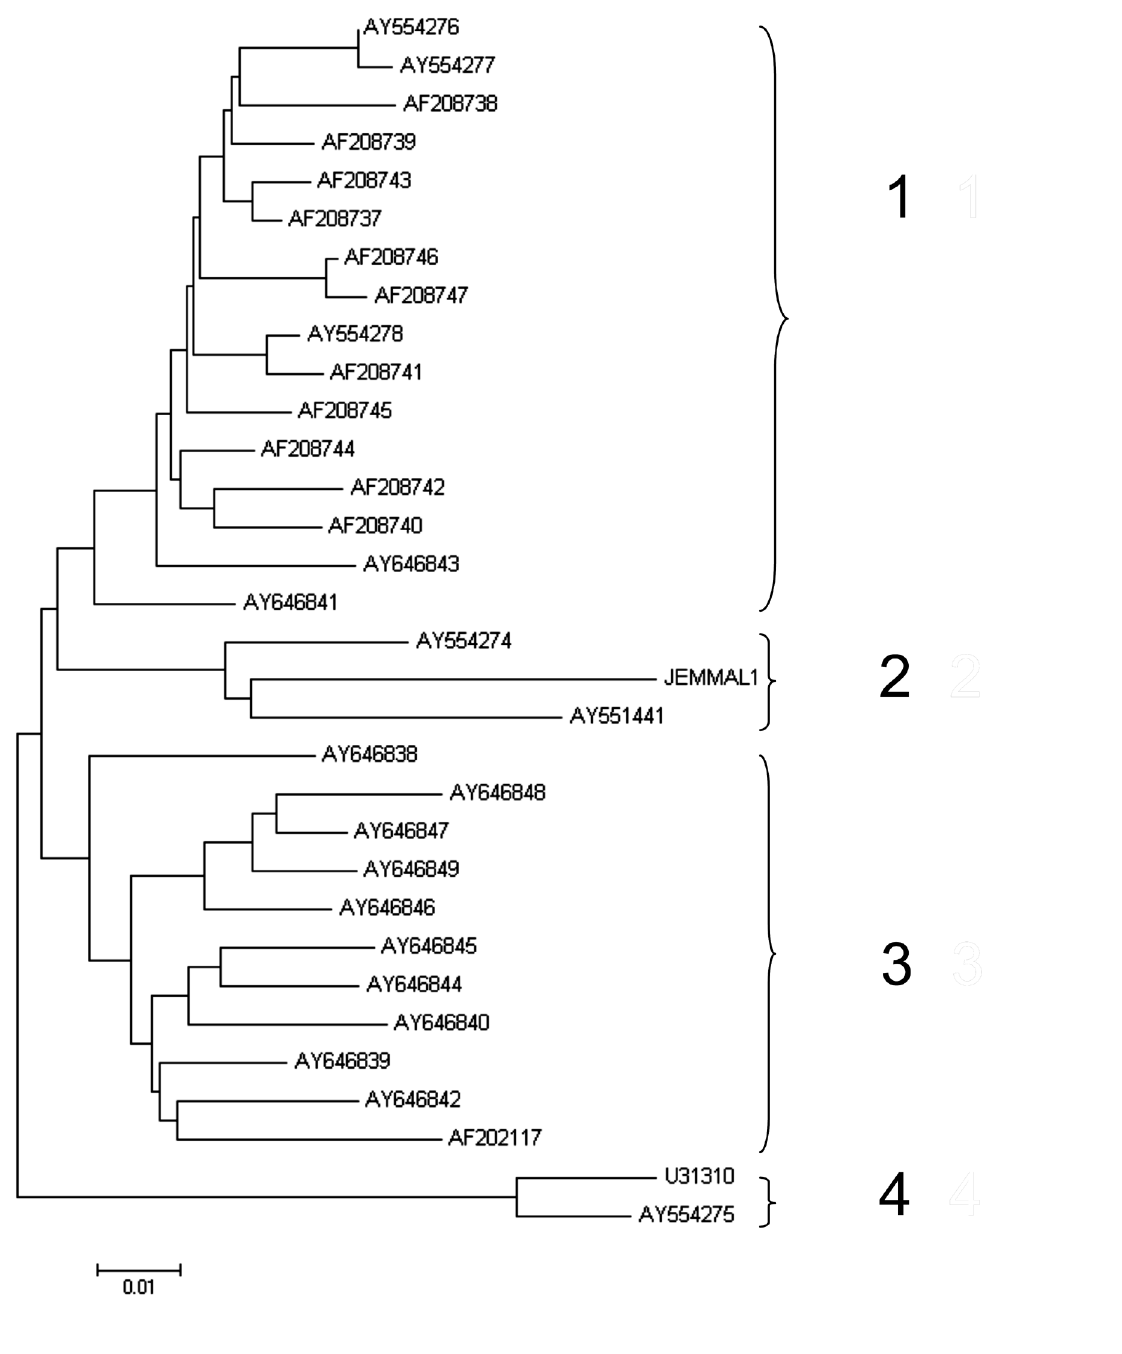
Figure 4. Dendrogram depicting phylogenetic relationships among Tunisian isolate Jemmal1, and other isolates available in the databanks. Four clades were delineated and indicated by Arabic numerals. The tree was produced using the NJ algorithm option of MEGA4.1β (Kumar et al ., 2008). Bootstrap analysis of 500 replicates was performed. The scale bar shows the number of substitutions per